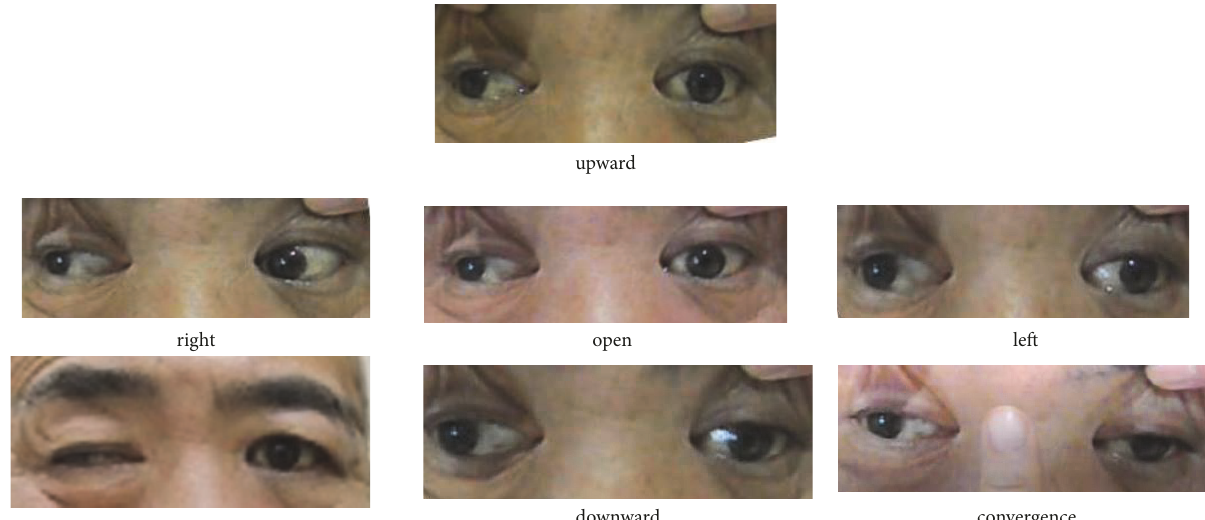
Figure 3: Findings of ptosis and oculomotor palsy one month after onset.